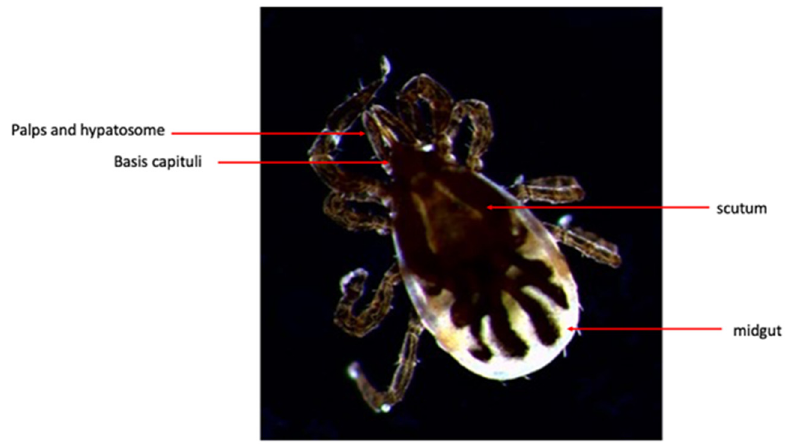
Figure 1. The anatomy of the adult I. scapularis hard tick underneath a dissection microscope. The red arrows indicate the different anatomical parts of the I. scapularis.